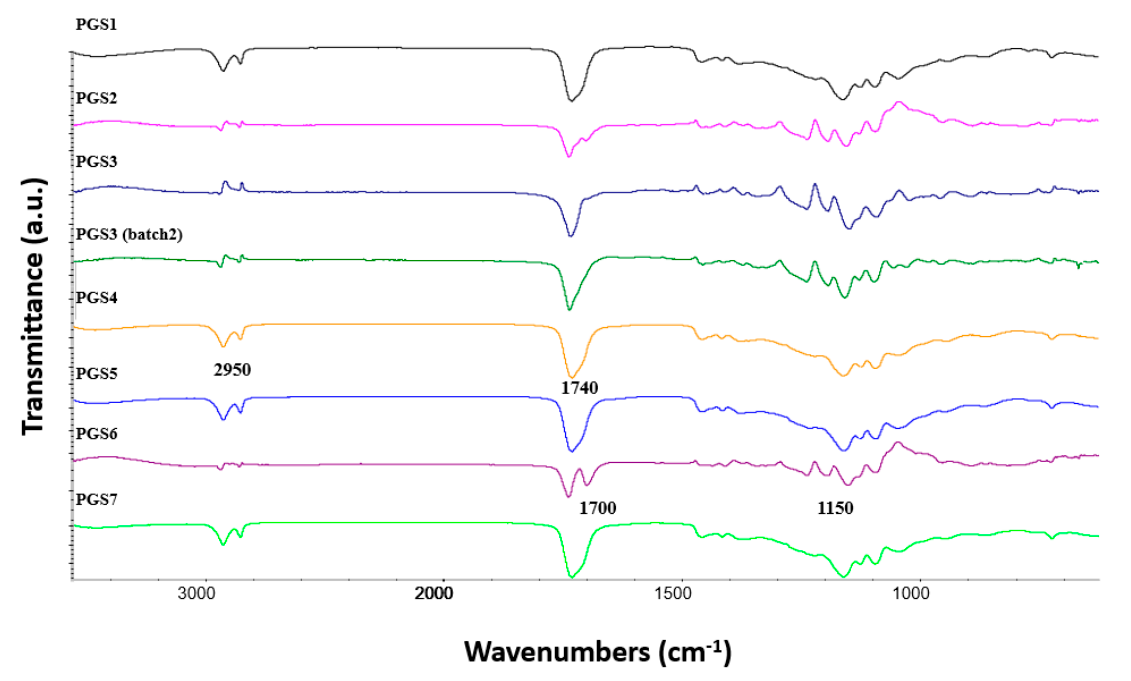
Figure 8. Infrared spectra of elastomer sheets from PGS1 to PGS7.